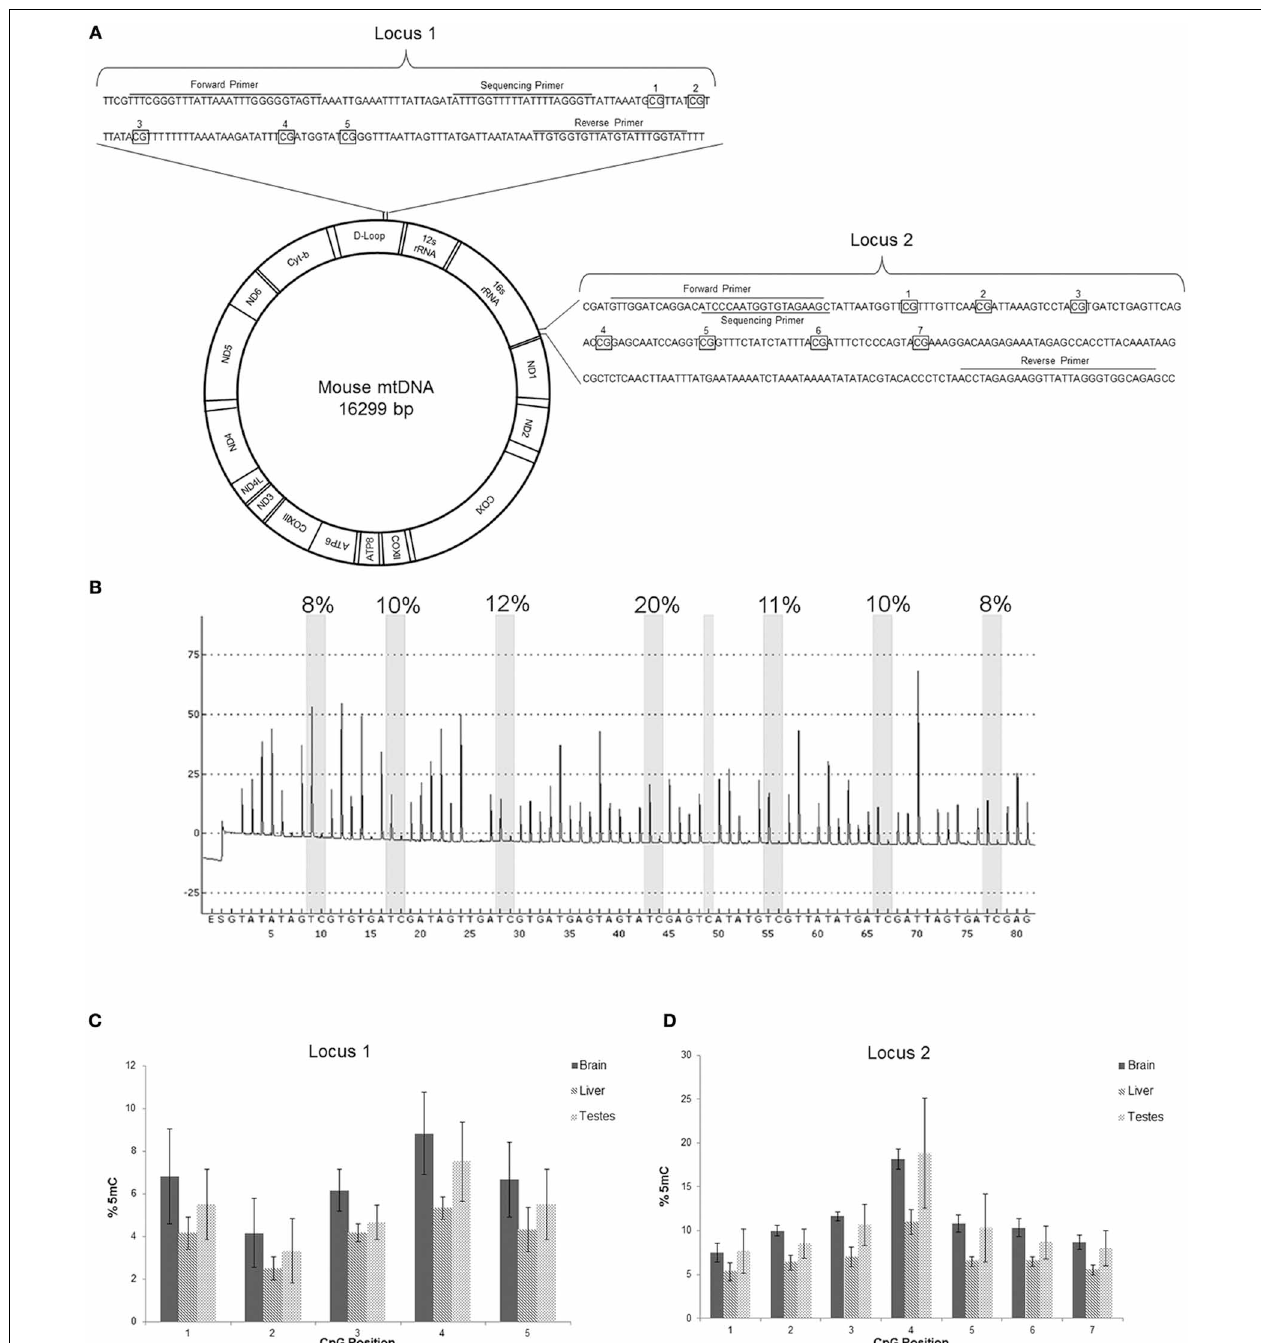
FIGURE 6 | mtDNA contains 5-methylcytosine (5mC). (A) Schematic of mouse mtDNA (Bibb et al., 1981) with depictions of the two locations assayed for 5mC. The first locus is in the D-loop, involved in mtDNA replication, and the second locus in the 16s rRNA encoding region. The primer locations are shown in sequences (wildtype or converted shown) with the CpG regions examined that are boxed and numbered. (B) Representative pyrogram from pyrosequencing of mouse brain mtDNA locus 2. The Y-axis is relative intensity (in arbitrary units) and the X-axis is the dispensation sequence showing the order of nucleotide addition to the reaction (E, enzyme; S, substrate). The seven thick shaded bars indicate the CpG